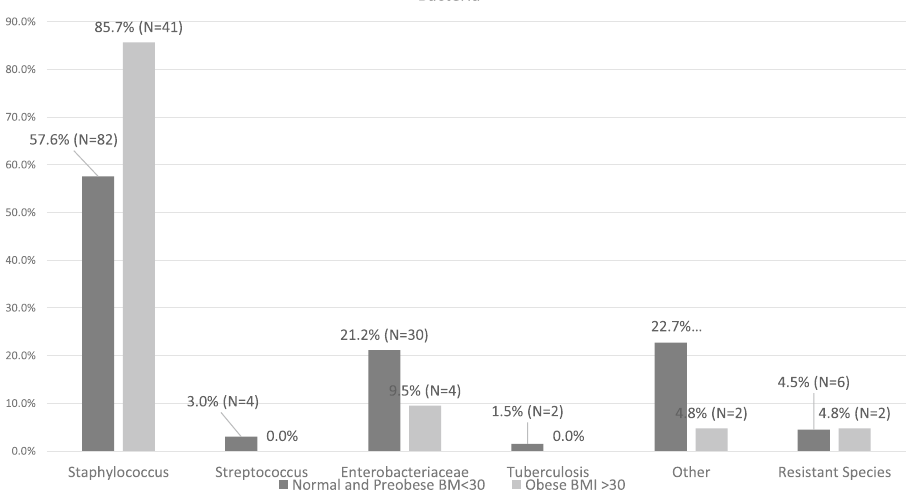
Figure 2. Bacteria that occur in obese and normal weight patients. Known as the most frequent pathogen, staphylococcus species occur substantially more often in obese patients with spondylodiscitis. In some cases, more than one pathogen was isolated.